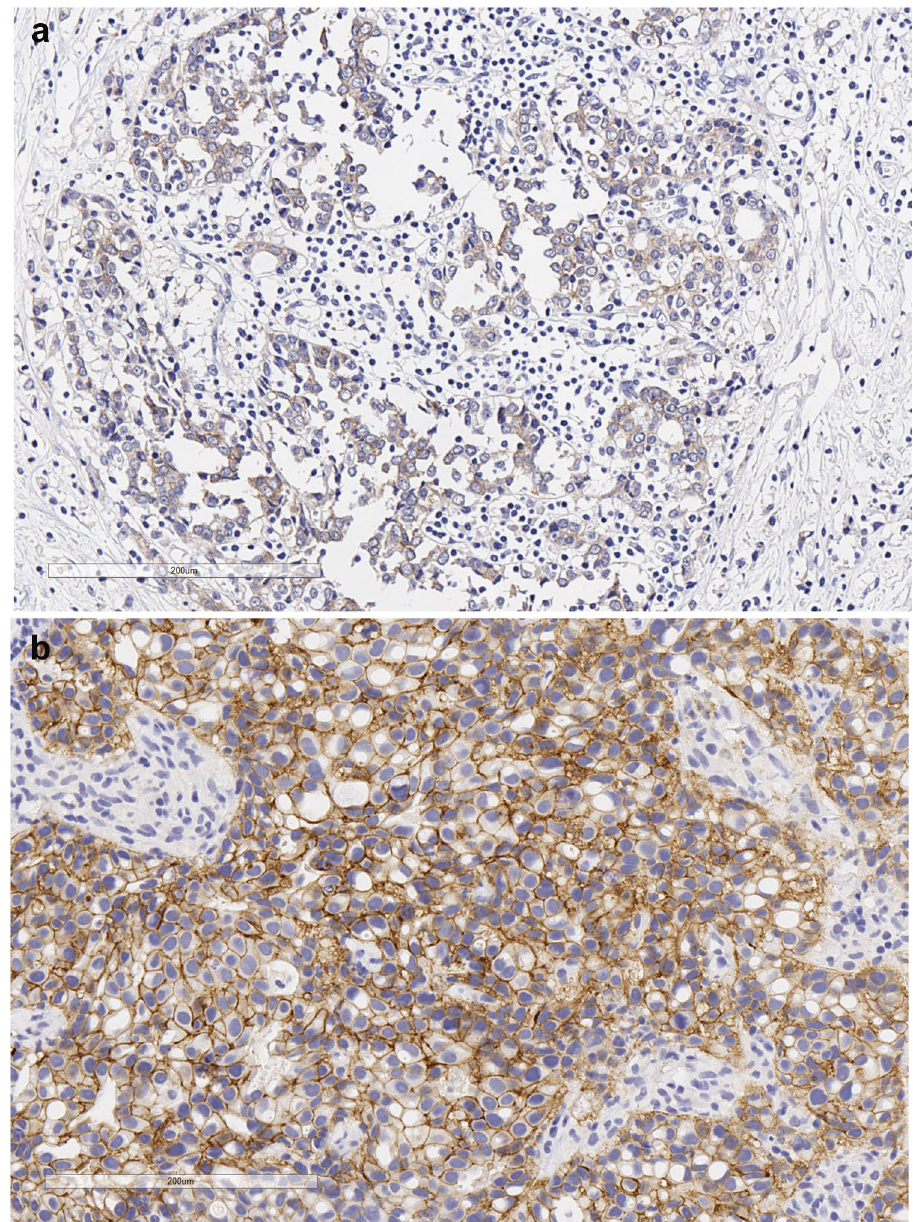
Figure 1. Histopathology features of a patient who switch the HER2 status from negative early breast cancer to positive in metastatic setting. In ( a ), at breast cancer diagnosis, HER2-assessment resulted as “Membrane staining that is incomplete and barely perceptible and within ≤ 10% of tumor cells. IHC: 0 negative”. At relapse ( b ), soft tissues from the left parasternal region were biopsied. HER2 expression resulted moderate, completed in > 10% of tumor cells. IHC: 2 + . The FISH resulted into gene